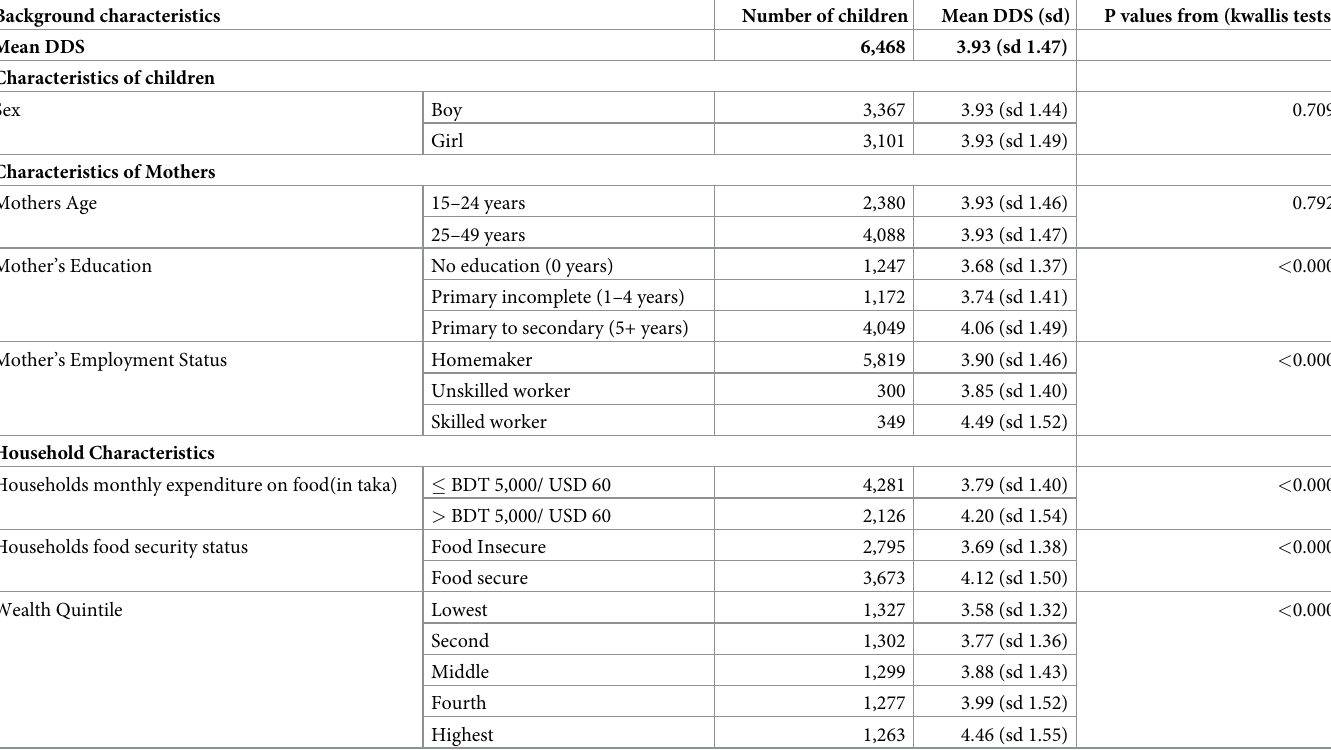
Table 2. Mean Dietary Diversity Scores (DDS) among children aged 6–59 months across different socioeconomic characteristics in rural areas of Bangladesh, 2014. Background